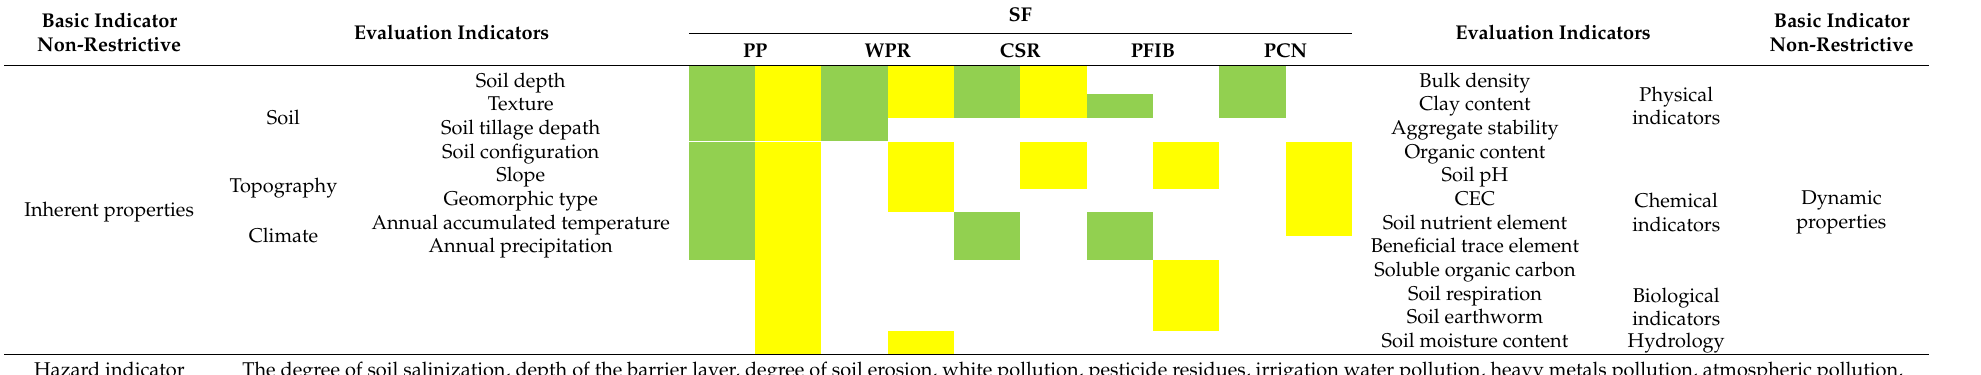
Table 1. SH evaluation indicators